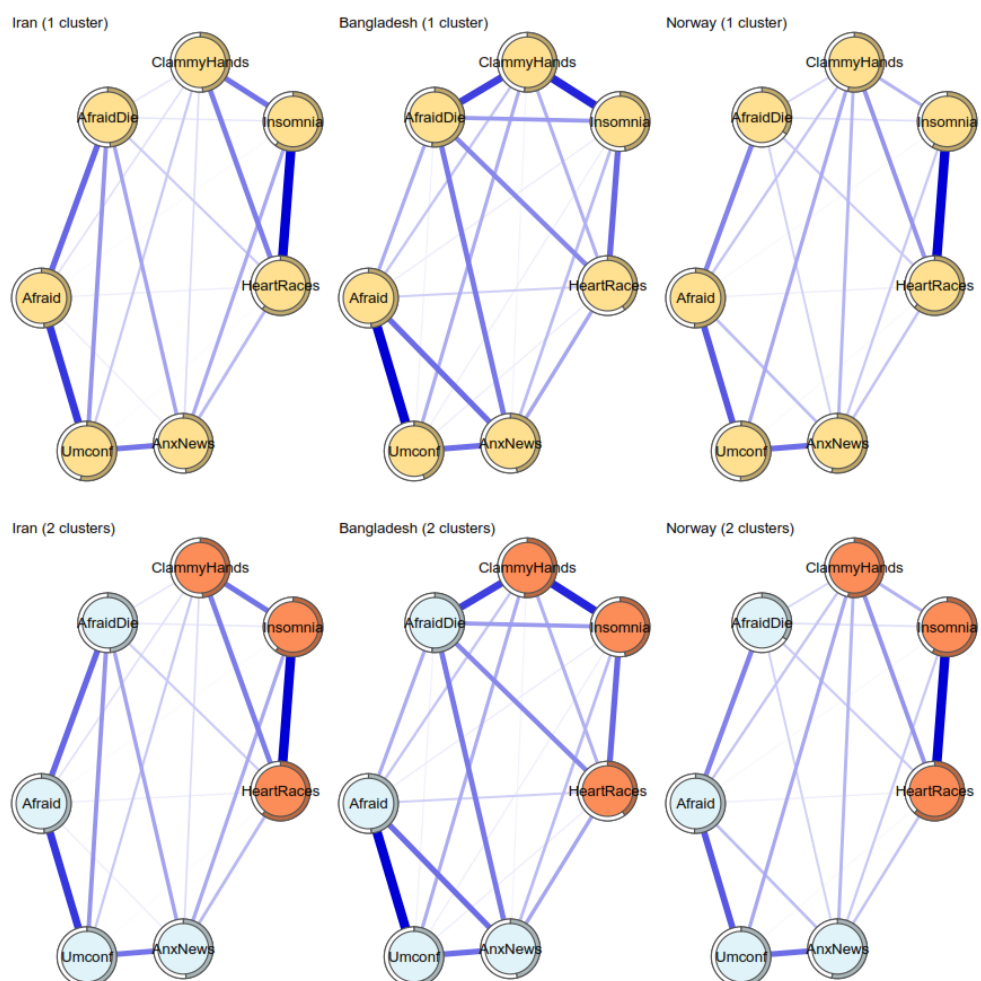
Figure 7. Network plots for Iran, Bangladesh, and Norway, the Fruchterman–Reingold algorithm, with an average display between groups. Note: Items are rounded in circles, with pies representing the explained variance (R 2 ) of each item. Lines connecting items represent correlations, blue = positive correlations, with thicker lines representing stronger correlations. Highly correlated items tend to be closer, while non-correlated nodes tend to be farther. AfD = afraid to die; Afr = afraid; Umc = uncomfortable; AnN = anxiety from the news; ClH = clammy hands, HrR = heart racing; Ins = insomnia.